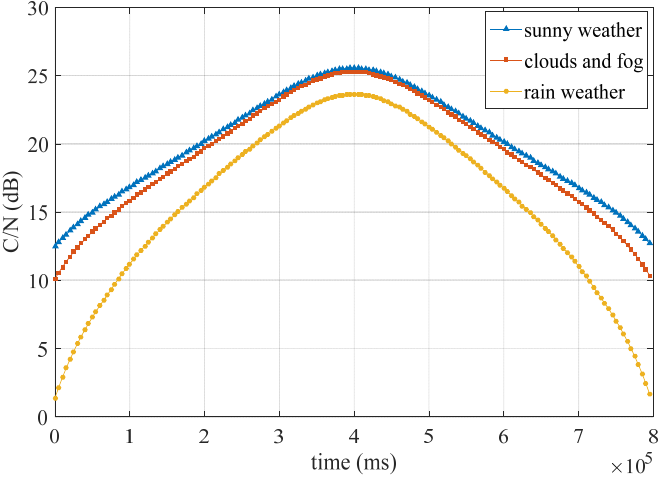
Figure 2. The link equation under different weather scenarios in a LEO communication window.